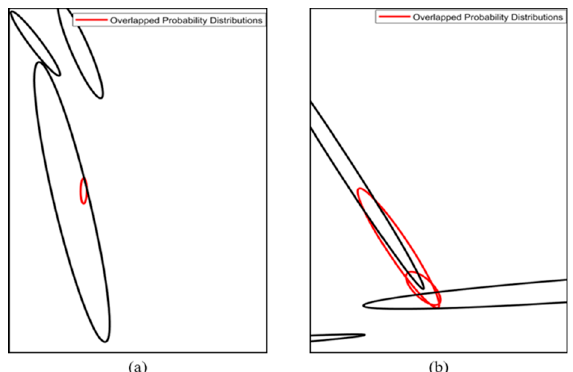
Figure 18. Result of overlapped probability distribution removal method. ( a ) Case of the smaller probability distribution inside a probability distribution, ( b ) Case of the probability distributions overlap with each other. Table 1. Example of the FRPDM.